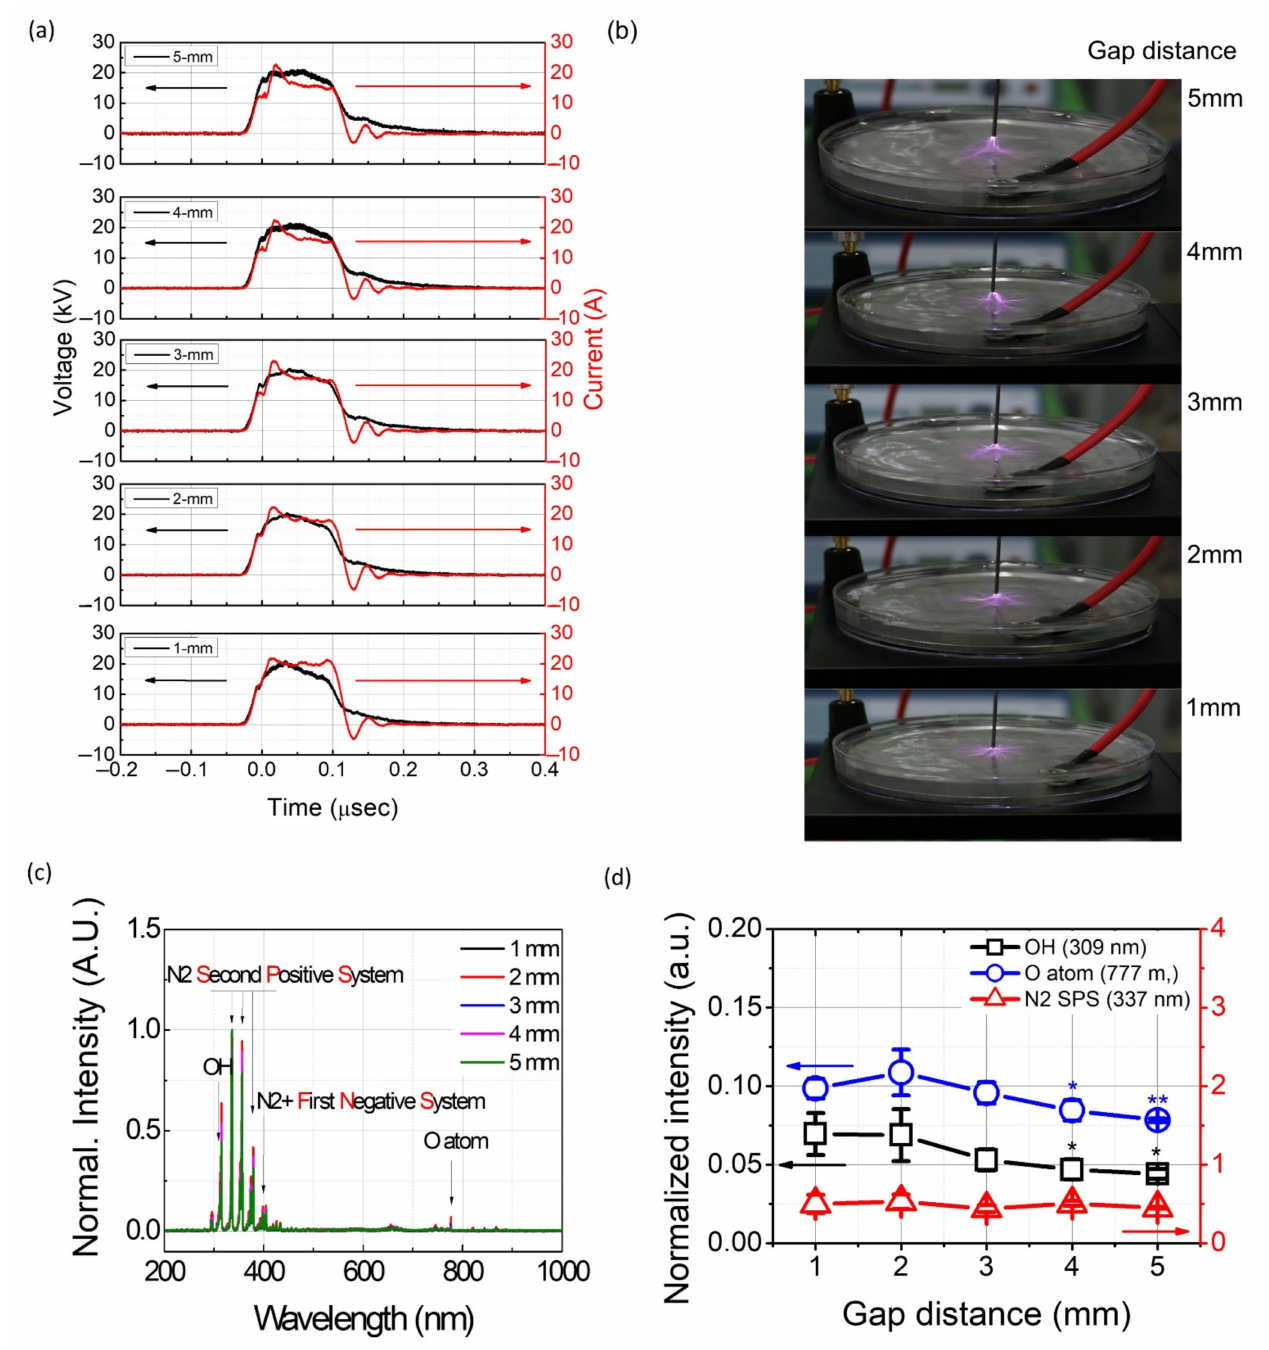
Figure 1. The characteristics of the plasma with different gap distances ( a ) current and voltage profile; ( b ) images of pin-to-water discharge; ( c ) OES (Optical Emission Spectra) of the plasma; and ( d ) relative intensity of N 2 SPS (337 nm), OH (309 nm), and O atom (777 nm). Results are presented as the mean ± standard deviation from three independent